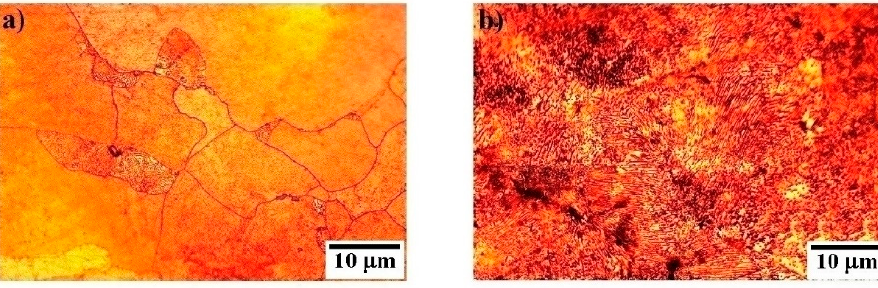
Figure 7. Optical micrographs of AZ91 alloy aged at 200 °C for a ) 4 h, b ) 24 h, c ) 96 h, and d ) 192 h. Figure 8. Optical micrographs of AZ91 alloy aged at 250 °C for a ) 4 h, b ) 12 h, c ) 96 h, and d ) 192 h. X-ray diffraction (XRD) measurements were applied for the studied samples aged at different temperatures for various aging durations. The recorded XRD series for all the investigated samples included both α -Mg with hcp crystal structure according to JCPDS card no. 65-3365 and body- centered cubic crystal structured ( β -Mg 17 Al 12 phase) according to JCPDS card no. 73-1148. The crystalline lattice parameters a , c, and c/a ratio were calculated for α -Mg matrix at different aging